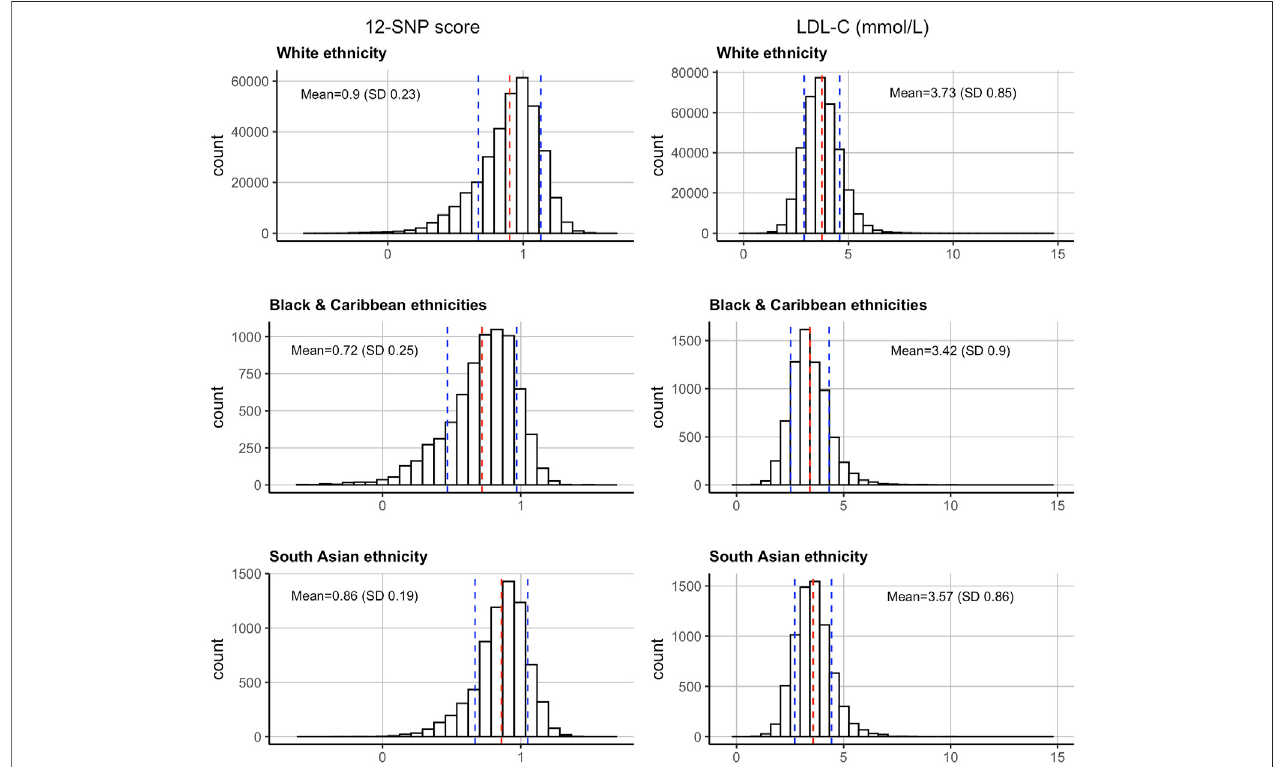
FIGURE 1 | Distributions of the 12-SNP score and LDL-C concentrations in the United Kingdom Biobank in self-reported White, Black & Caribbean, and South Asian ethnicities. The mean and SD are depicted by dotted red and blue lines respectively. LDL-C, low-density lipoprotein cholesterol; SD, standard deviation.